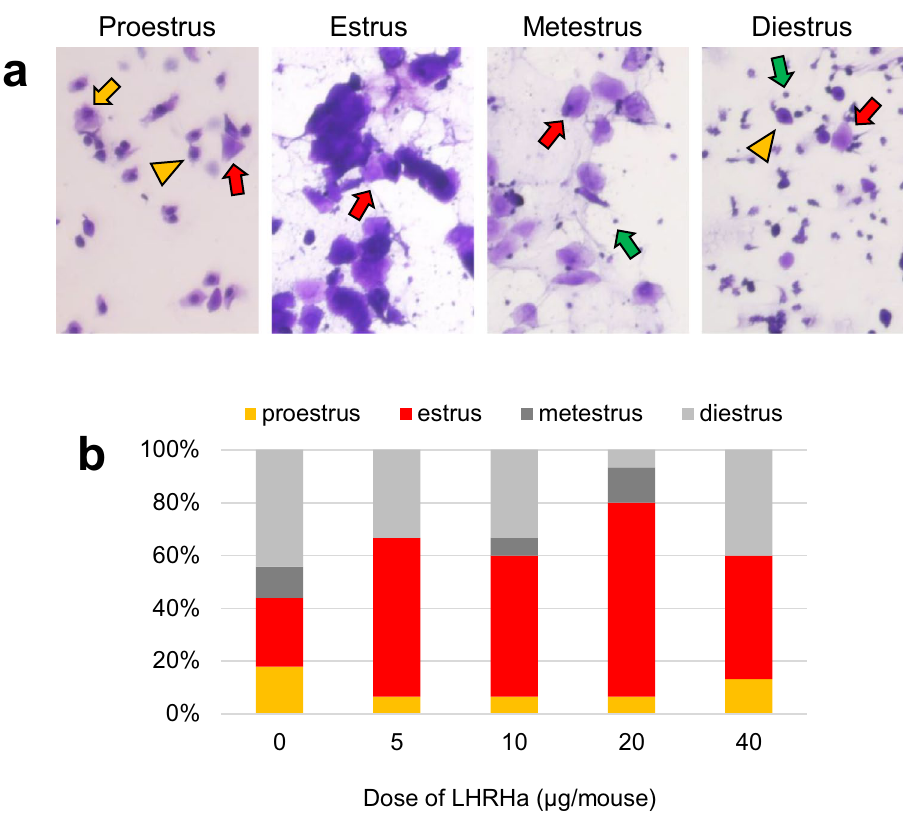
Figure 1. Dose optimization of LHRHa for the estrus synchronization. ( a ) Vaginal cytology of each estrus stage. The proestrus stage includes mainly small nucleated epithelial cells with round shapes, and cornified epithelial cells are also found in late proestrus. The Estrus stage is characterized by predominant anucleated cornified epithelial cells. Metestrus is characterized by a combination of anucleated cornified epithelial cells and leukocytes. Diestrus is characterized by a combination of leukocytes, small and large nucleated epithelial cells, and a low number of cornified cells. The green arrows indicate leukocytes, the yellow arrow indicates large nucleated epithelial cell, the yellow arrow heads indicate small nucleated epithelial cells, and the red arrows indicate anucleate cornified epithelial cells. ( b ) Rates of each estrus stage at 4 days after LHRHa administration in each dose. The actual measurement value was shown in Table 1.